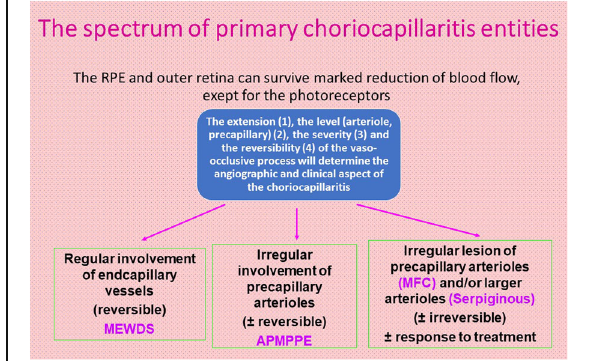
Fig. 15 Schematic classification of PICCPs according to suspected location of vaso-occlusive